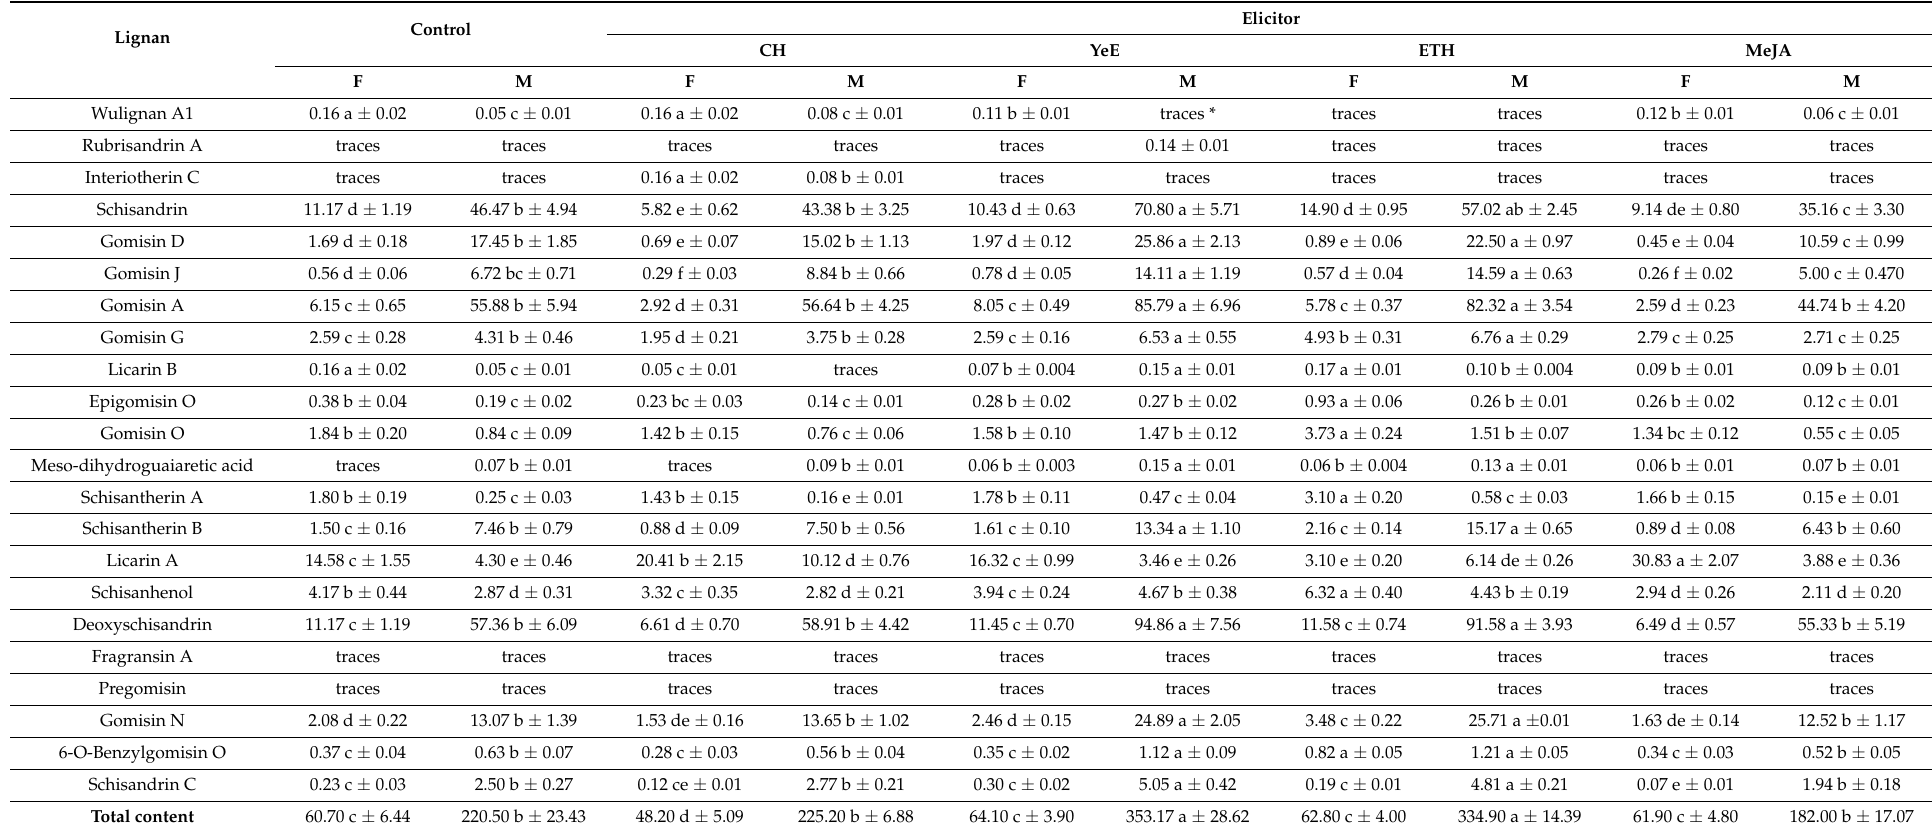
Table 4. Accumulation of lignans (mg/100 g DW) in agitated cultures of S. rubriflora lines F and M 4 days after addition of elicitor. Data expressed as the